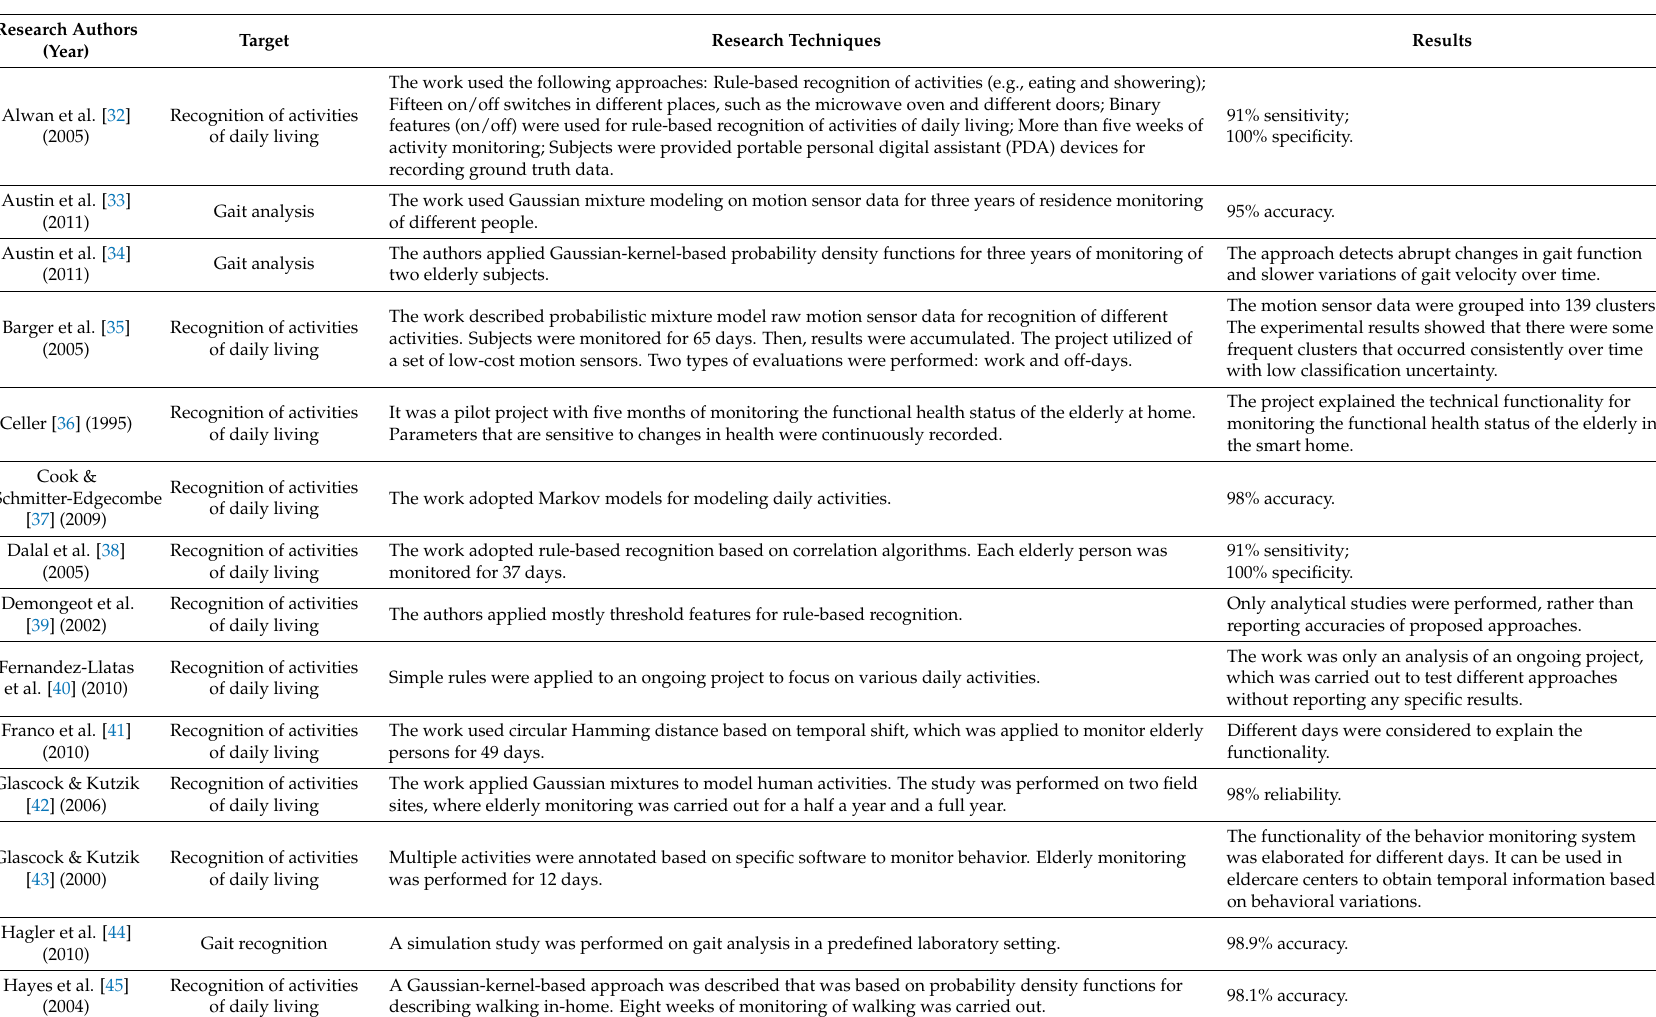
Table 2. Summary of research works that use passive infrared motion sensor